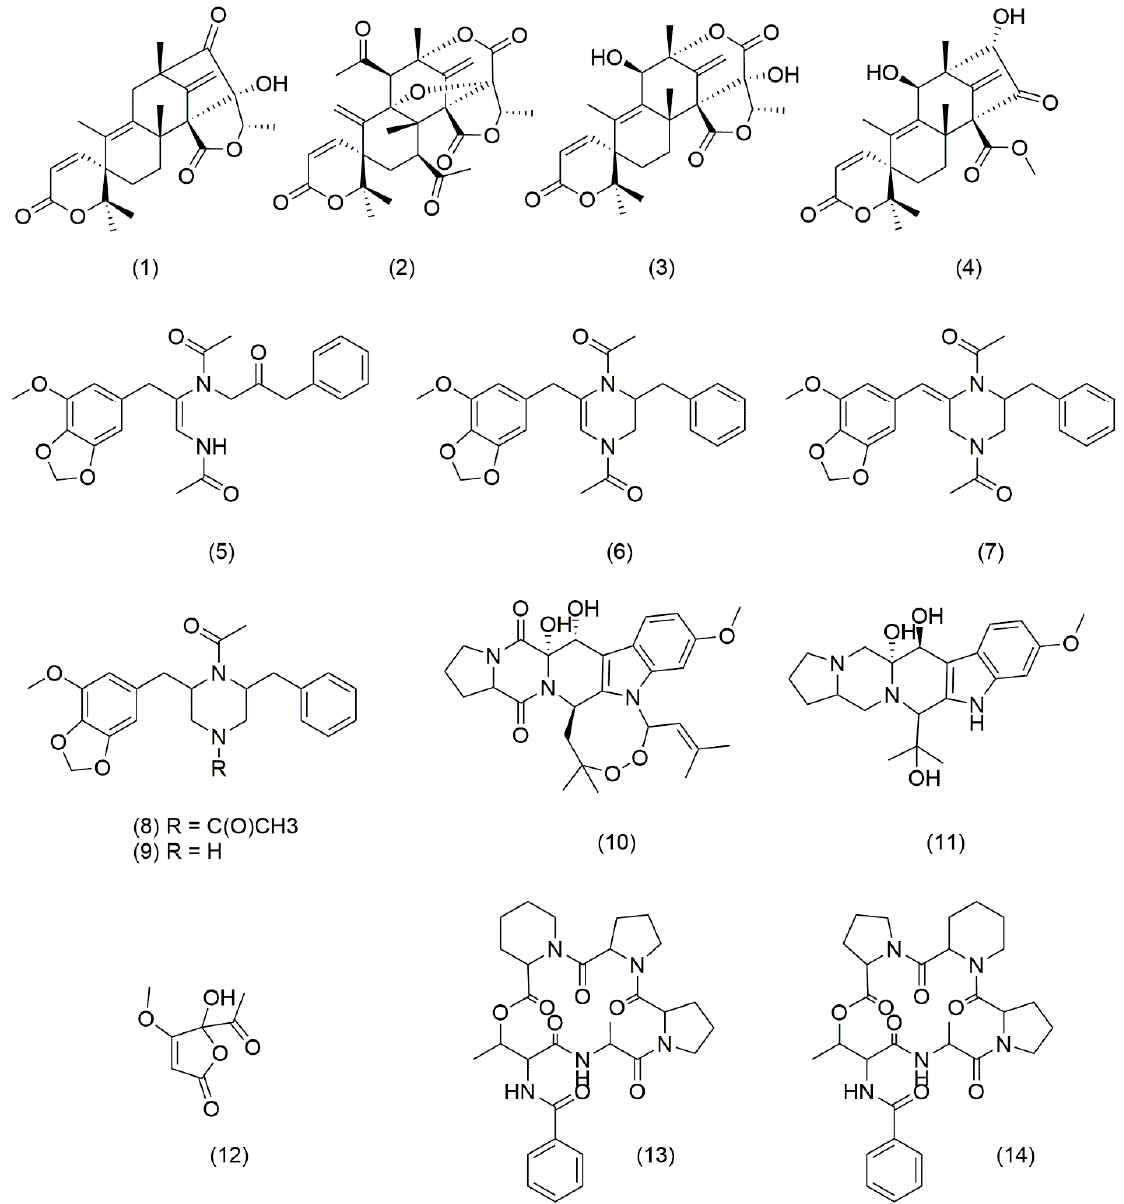
Figure 6. Chemical structures of metabolites annotated in this